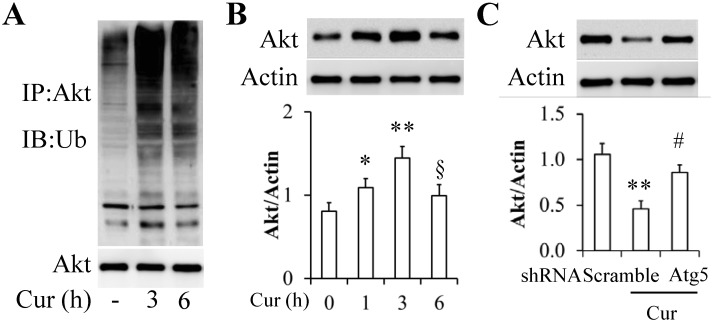
Curcumin regulated Akt ubiquitination and aggregation.(A) Akt ubiquitination. (B) Akt expression in insoluble fractionation of curcumin-treated cell. (C) Akt expression in insoluble fractionation of Atg5 knockdown cell. Data are means ± SEM. (n = 3).*p<0.05 vs control group. § p<0.05 vs 3 h-treated group. # p<0.05 vs curcumin-treated group.